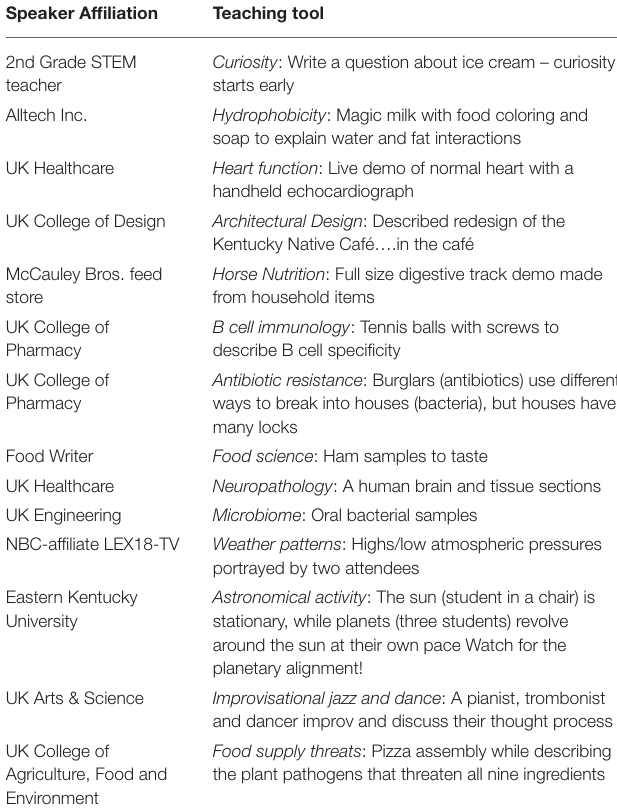
TABLE 2 | Teaching tools established by speakers at the EiS